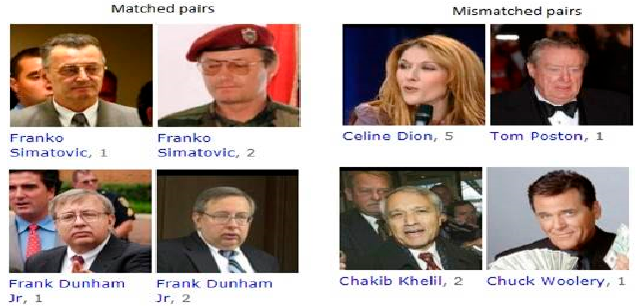
/ mismatched pairs in Figure 7. Example of matched/mismatched pairs in LFW. Figure 7. Example of matched/mismatched pairs in LFW. Figure 7. Example of matched